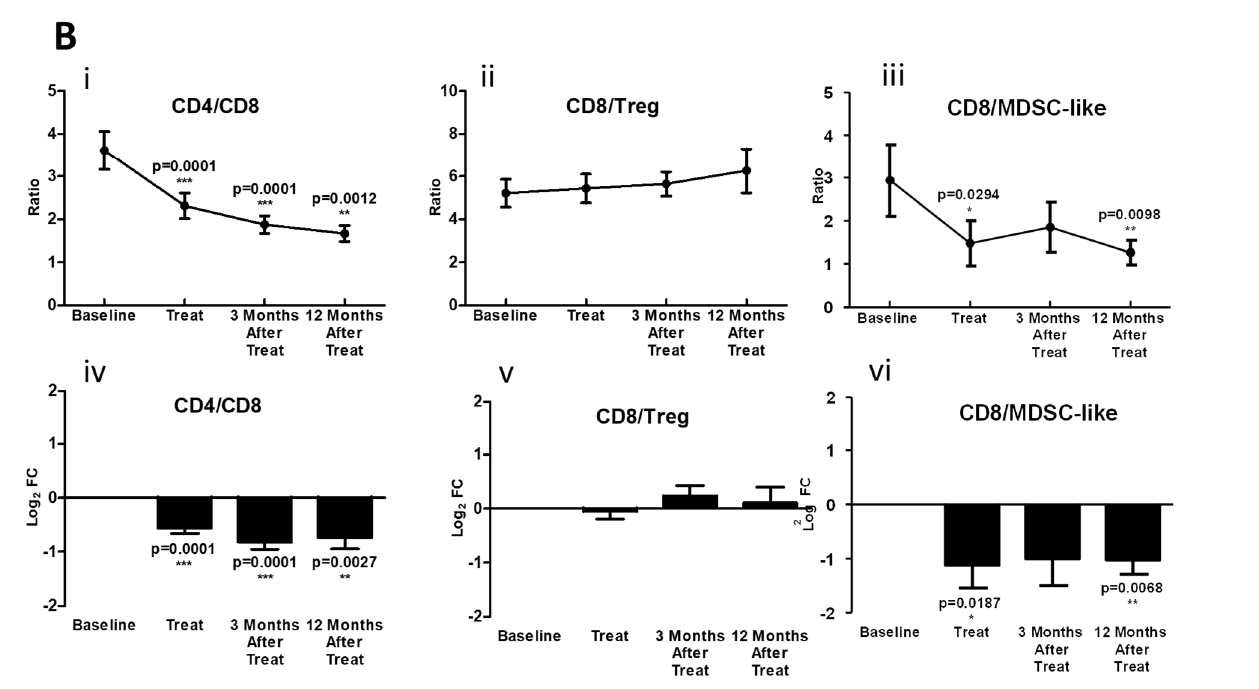
Figure 3. Effect of PD-1 blockade during chemoradiotherapy on circulating immunocytes. ( A ) time course of changes in the relative number (expressed as percentage of live white cells) of effector (CD4+ ( i ) and CD8+ ( ii )) T cells, B cells ( iii ) and suppressor (MDSC-like ( iv ) and Treg cells ( v )) before and after treatment. ( B ), CD4+/CD8+ ( i ), CD8+/Treg ( ii ) and CD8+/MDSC-like cells ( iii ) and expressed as the Log2 fold change (Log2 FC) of these ratios with respect to baseline ( iv – vi ). * ( p ≤ 0.05), ** ( p ≤ 0.01) and *** ( p ≤ 0.001) with respect to